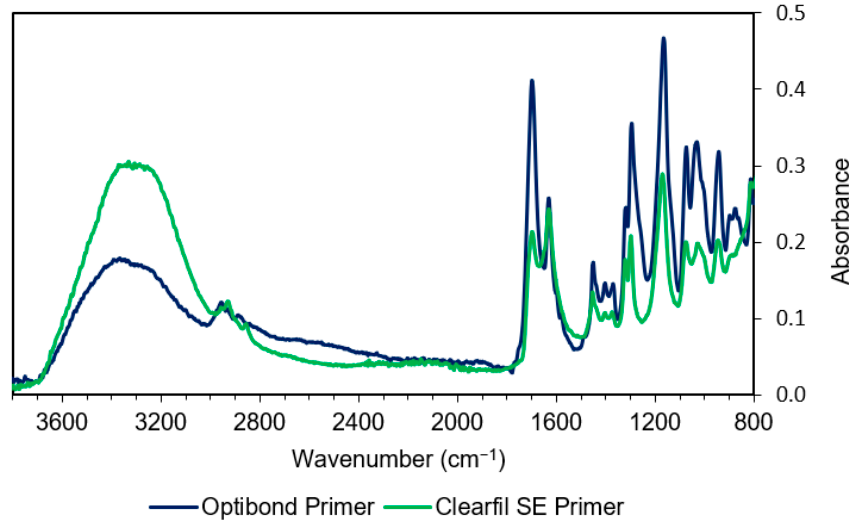
Figure 3. Comparison of IR spectra of both primers. Note the higher absorbance in the –OH region (3300 cm − 1 ) and lower methacrylate peaks at 1700, 1320, 1300, 1160, 1080, 1050, and 940 cm − 1 with CFSE due to its greater water content. Table 3. IR assignments for R groups of monomers in OBFL and CFSE primers and